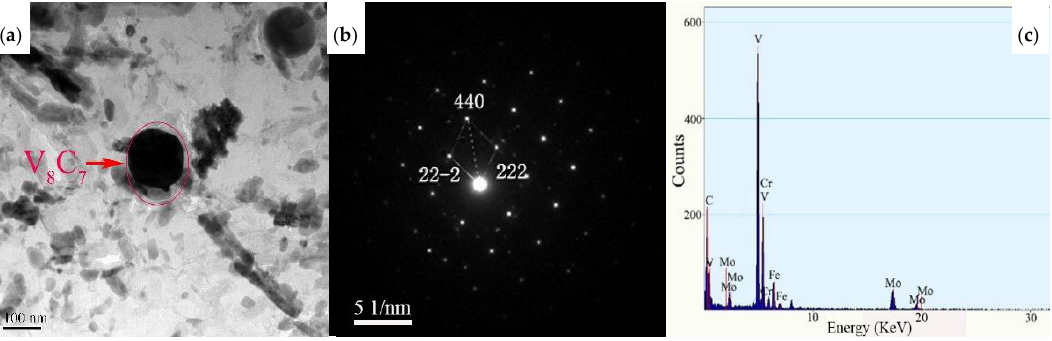
Figure 4. Precipitates of V 8 C 7 near the surface of the H13 ingot after tempering: ( a ) Morphology by TEM; ( b ) SAED (Selected Area Electron Diffraction) analysis; ( c ) EDS (Energy Dispersive X-ray Spectrum) analysis.